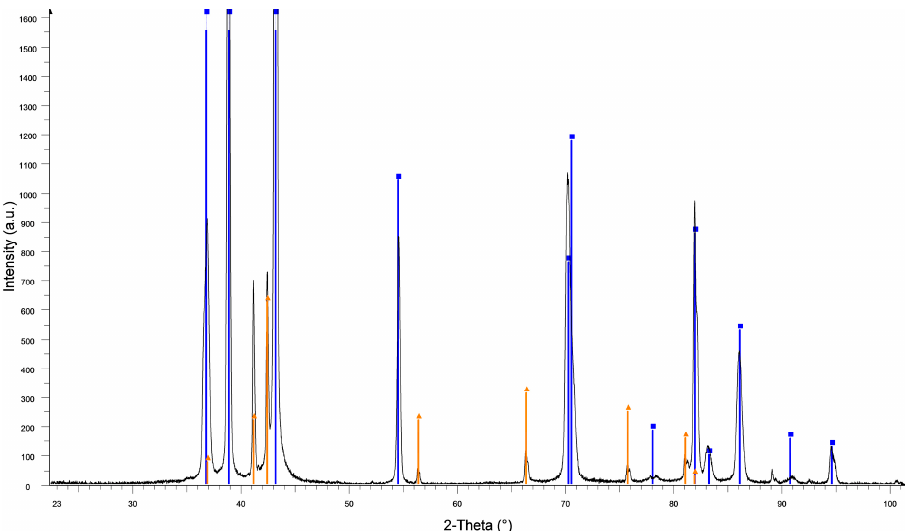
Figure 3. X-ray diffraction (XRD) pattern (black) of Zn-4Ag after thermomechanical treatment. The phases Zn (03–065–3358, blue) and ε -AgZn 3 (00–025–1325, orange) were identified.